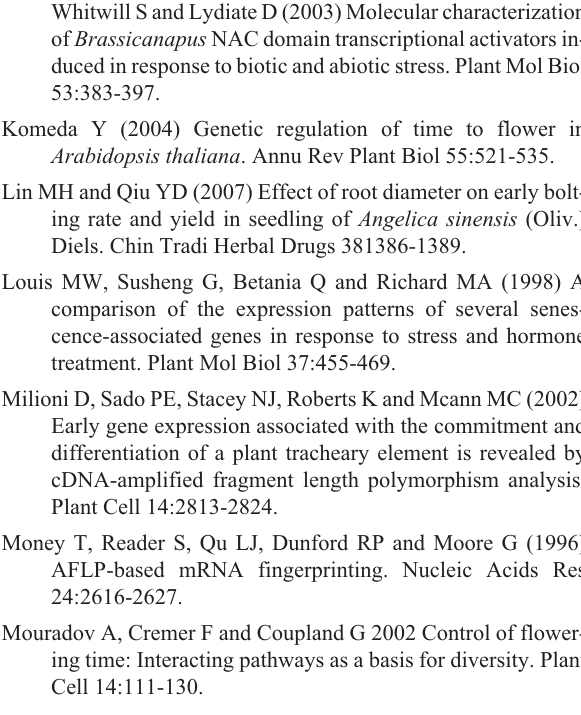
Table S1 - Sequences of the primers used for